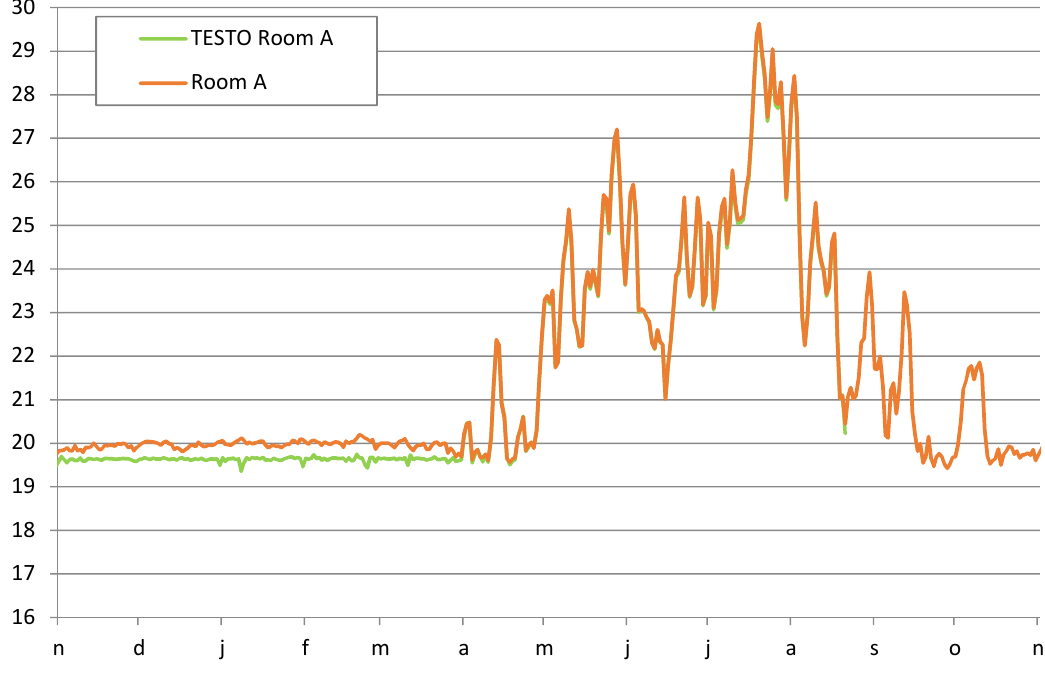
Figure 10. Daily mean indoor temperatures in room A, as measured by the ventilation system (Room A) and by the TESTO device (TESTO Room A).